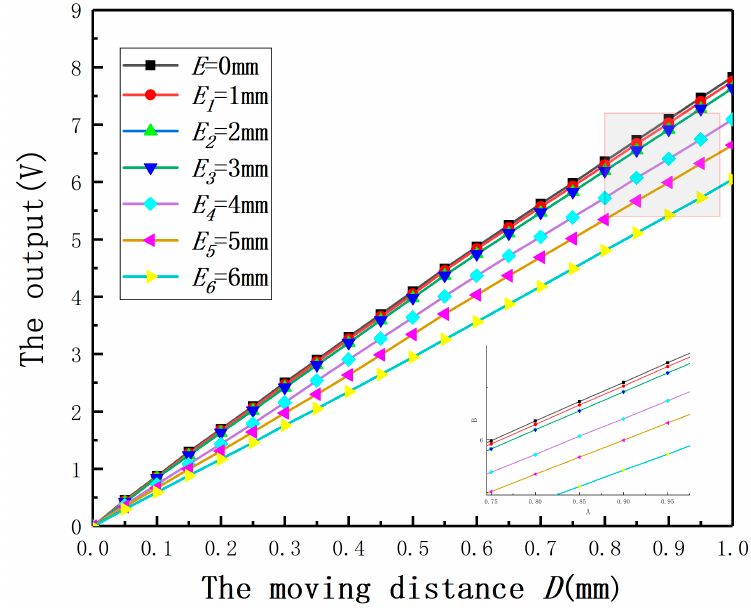
Figure 24. The relationship between the output and the moving distance under different eccentricities.